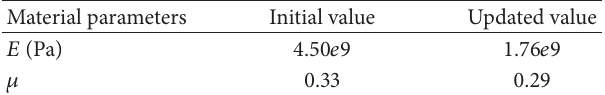
Figure 12: Measured nonlinear FRF at sensor location A. Table 2: Initial and updated material parameters.